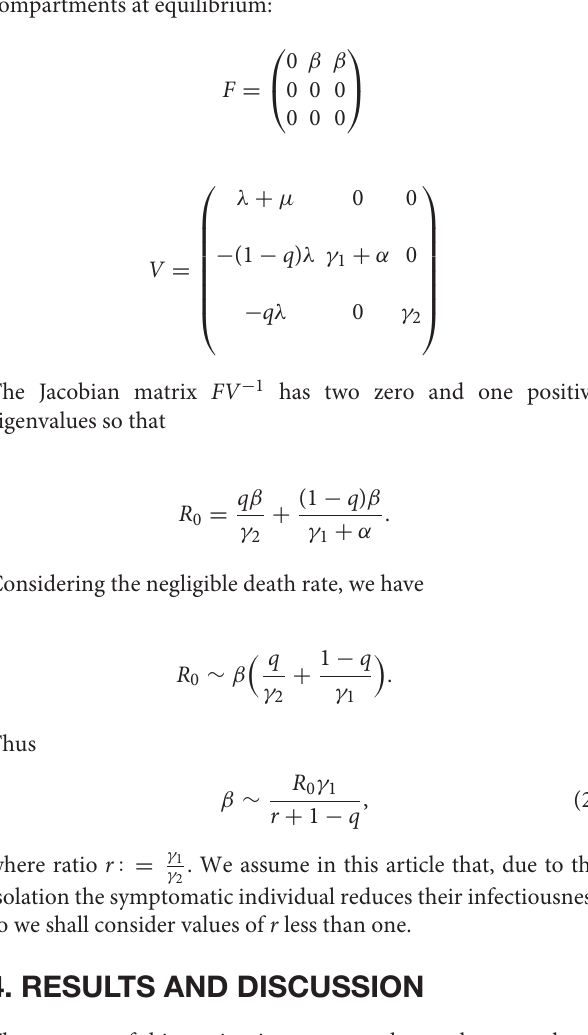
where N = S + E + I s + I a + R + D is the fixed total